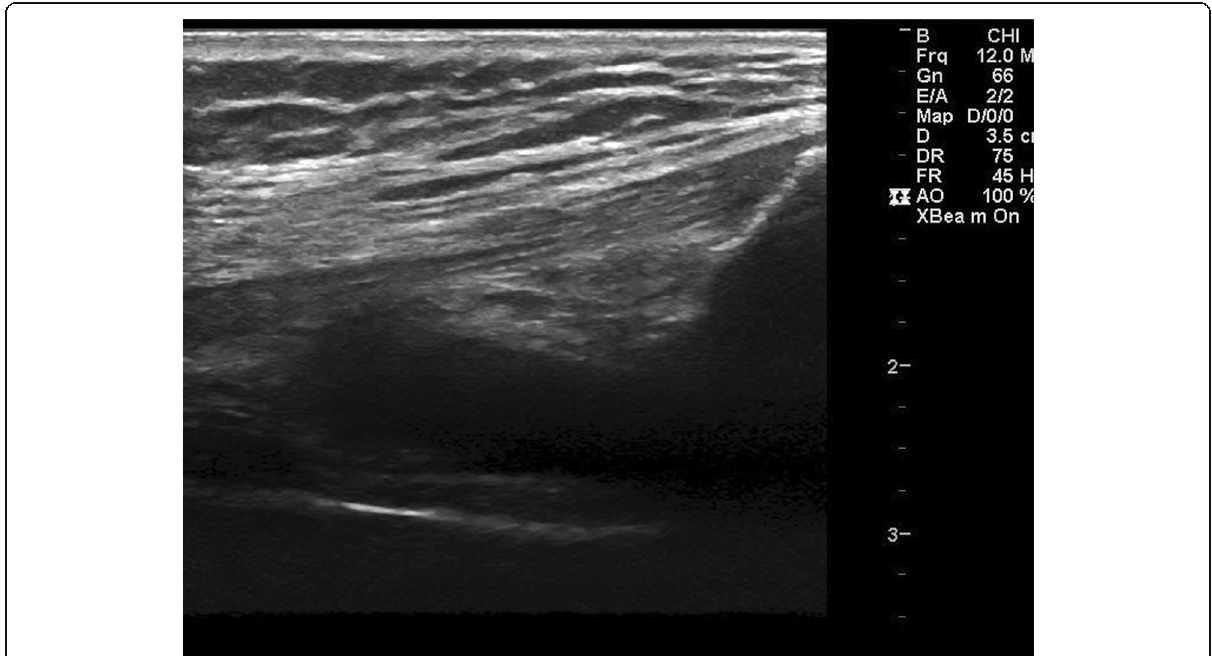
Fig. 1 Moderate right knee synovial effusion in the supra-patellar bursa of a 38-year-old female RA patient with a disease duration of 8 years and DAS-28 score of 4.5. She had combined high serum and synovial IL-37 of 440 pg/ml and 670 pg/ml respectively, and she was receiving MTX 17.5 mg/week. RA, rheumatoid arthritis; DAS, disease activity score; IL-37, interleukin 37; MTX, methotrexate. Straight arrow, quadriceps tendon; curved arrow, upper border of the patella; star, suprapatellar effusion